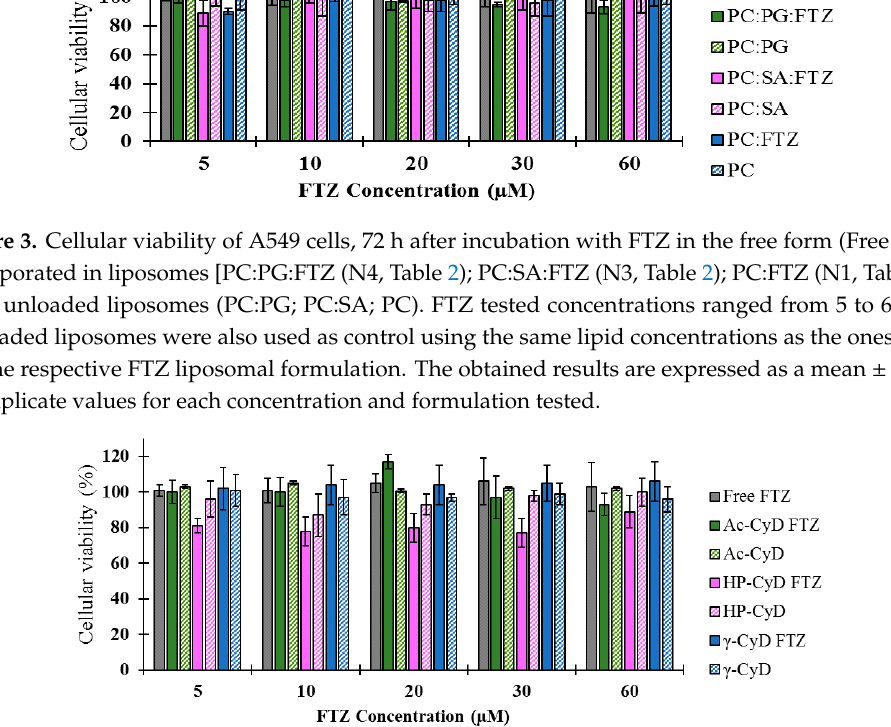
Table 133: txfonts / pxfonts Upright Greek Letters